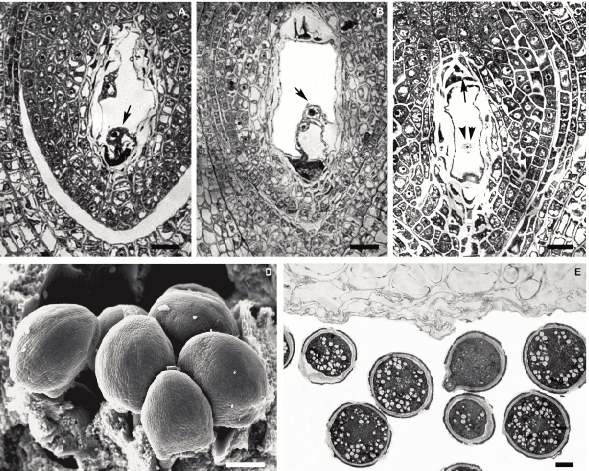
Fig. 5 - Details of the ovary and pollen grains of a flower on anthesis stage of B. G. Forst. A-C, embryo sac with egg cell (A, arrow), synergids (B, arrow) and antipodes (C, arrow) and polar nuclei (C, arrows head); D, SEM micrograph of ovules on the basal insertion of ovary; E, mature pollen grains with cytoplasm rich in starch grains. Bars: A-C= 200 µm; D= 100 µm; E= 10 µm.